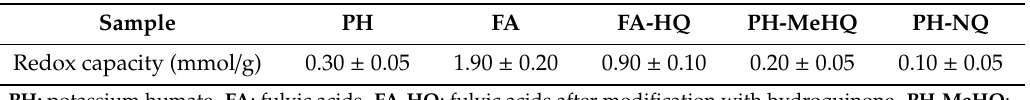
Table 1. Redox capacity of natural and quinone-enriched